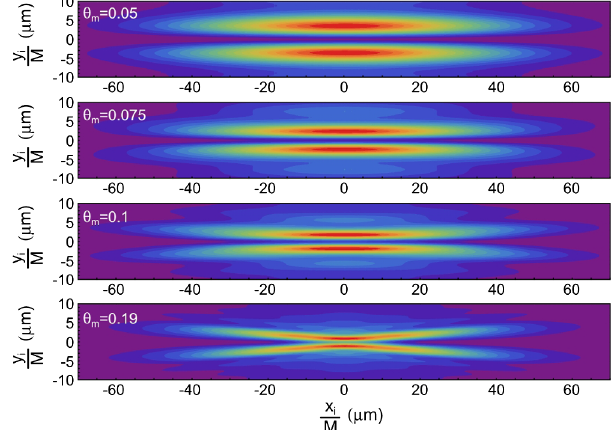
FIG. 5. Calculated two-dimensional beam images for a beam size of σ x ¼ 30 μ m, σ y ¼ 0 . 4 μ m and for different numerical apertures θ m , in top-to-bottom order θ m ¼ 0 . 05 , θ m ¼ 0 . 075 , θ 0 . 10 , and θ 0 . 19 m ¼ m ¼